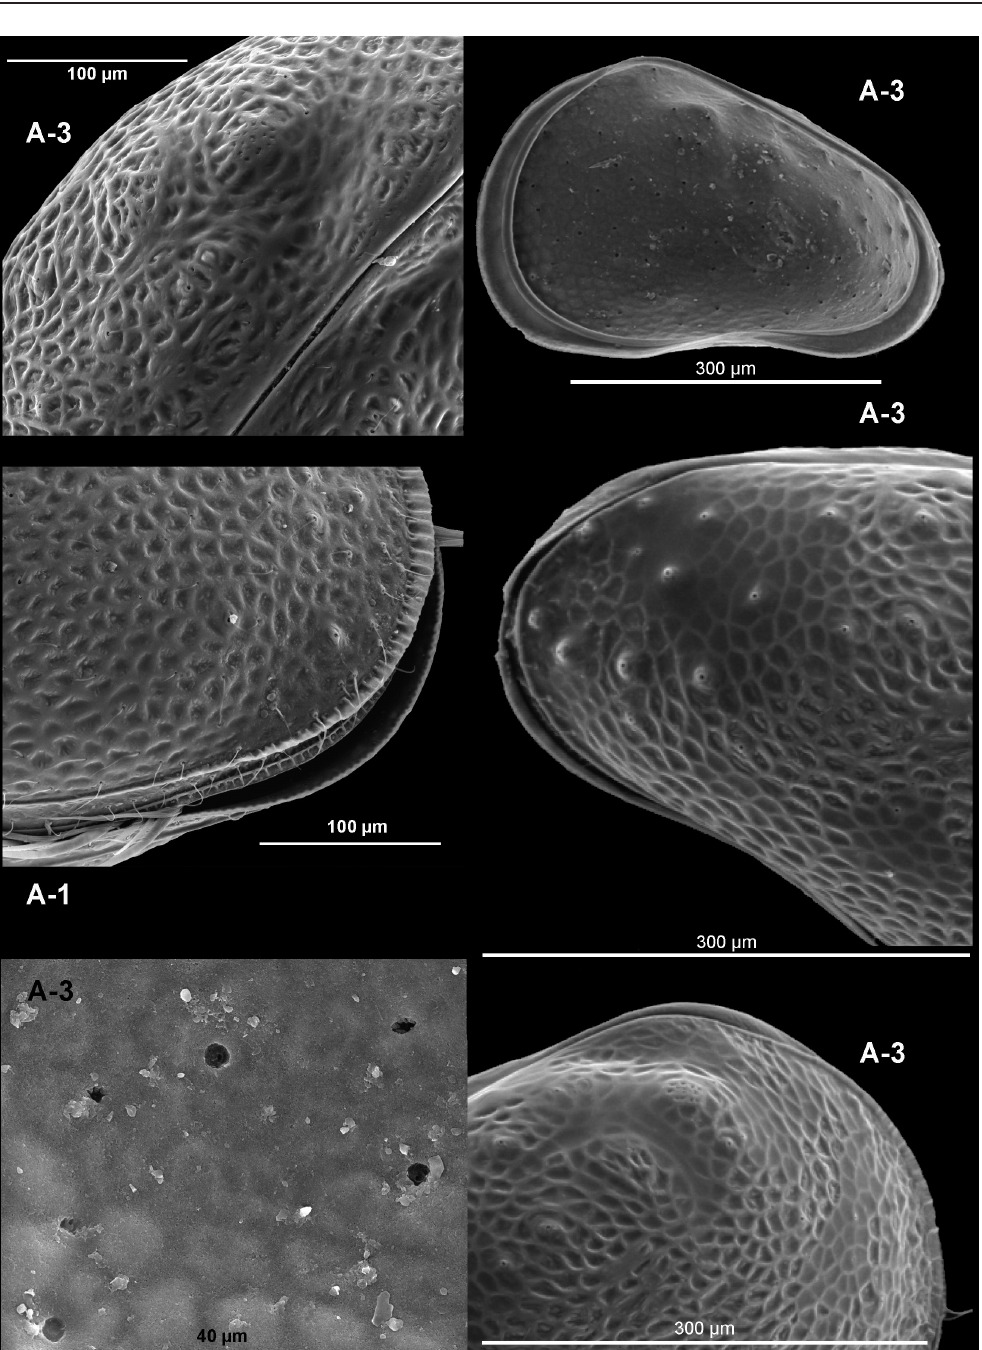
Fig. 18. Specimens of Bennelongia cf. barangaroo nov. sp. from McNeil Claypan, to show specific features of juvenile specimens. Top left image shows the poorly pronounced domes in the dorsal region of the LV of an A-3 specimen. Top right image shows an internal view of an A-3 that shows the less pronounced inner list and the depression located opposite the cones and the possible larger depression matching the external dome. The middle images show the cones with the lips near their apex. Bottom left image shows the larger pores on the inside of the valve, that are connected to the opening of each pore on the apex of each cone. Bottom right corner image shows the highly reticulated texture of an A-3 valve and the domes that are not as pronounced as in other Bennelongia species (e.g., compare to B. nimala nov. sp. in Fig.